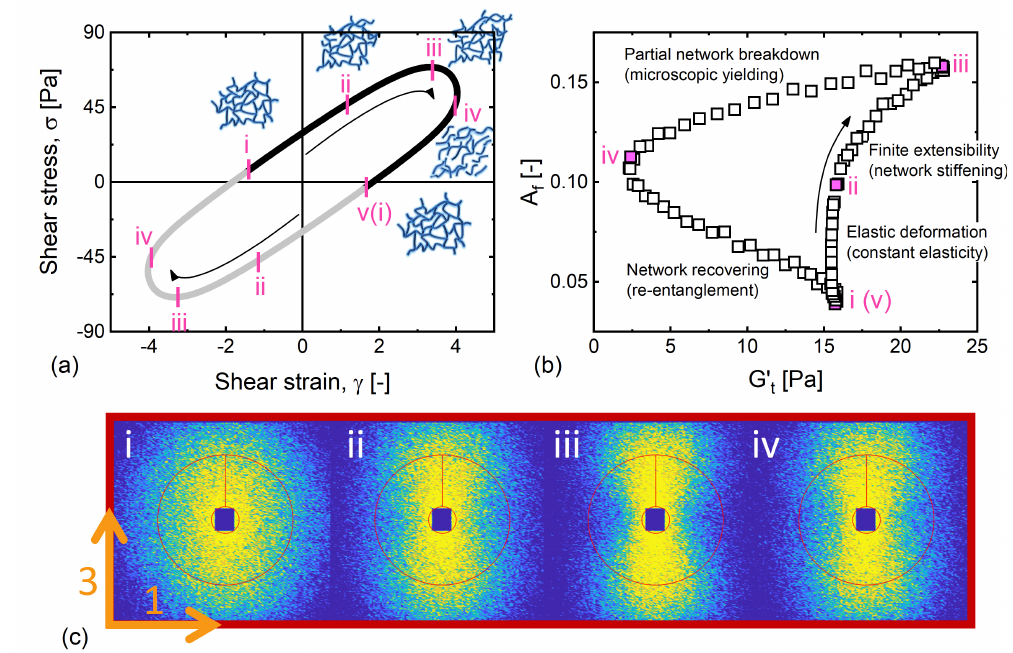
Figure 8. The microstructural evolution during the course of oscillation at De = 5.26. The structure evolves in a sequence: network undergoing purely elastic deformation in stages i–ii, further stretching network resulting in stiffening responses (finite extensibility) in stages ii–iii, network broken into segments (microscopic yielding) at large strain in stages iii–iv, and network reforms to initial state in stages iv–v. ( a ) Shear stress versus shear strain. ( b ) The degree of alignment is plotted as a function of time-dependent elastic modulus. ( c ) 2D SANS patterns in the corresponding stages during a LAOS